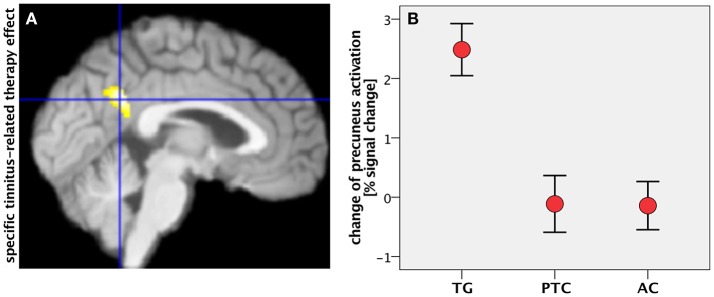
(A) Specific tinnitus-related therapy effect by contrasting task-negative activity between treated patients (TG) and “treated” healthy controls (AC) within the mask for therapy-related effects (median plane). (B) Change of precuneus activity (in percent signal change) in all groups after the study week. Error bars: standard error of mean.